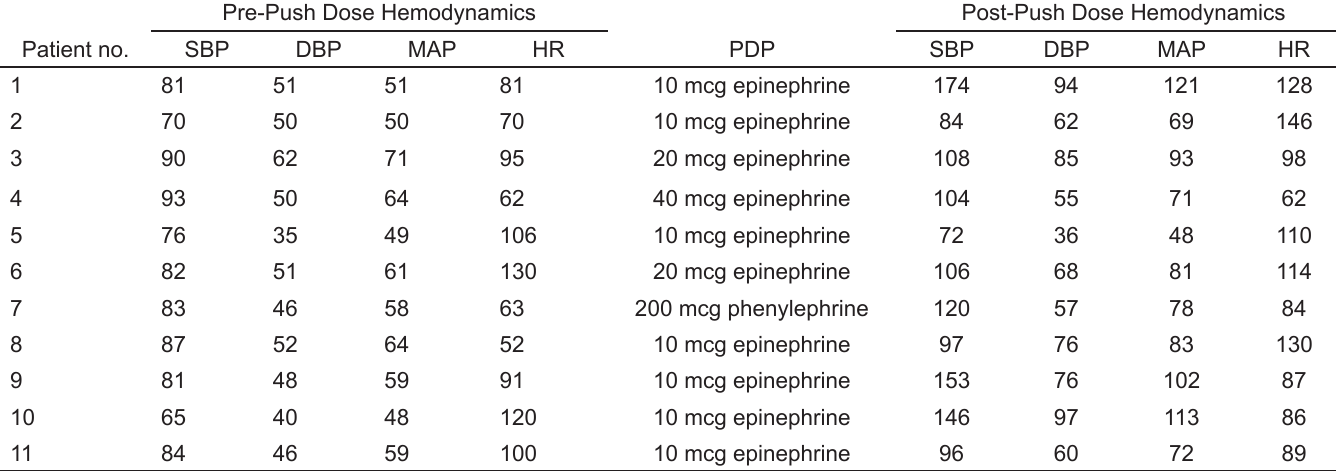
Table 2. Change in hemodynamic parameters in relation to push-dose pressors. Patient no.